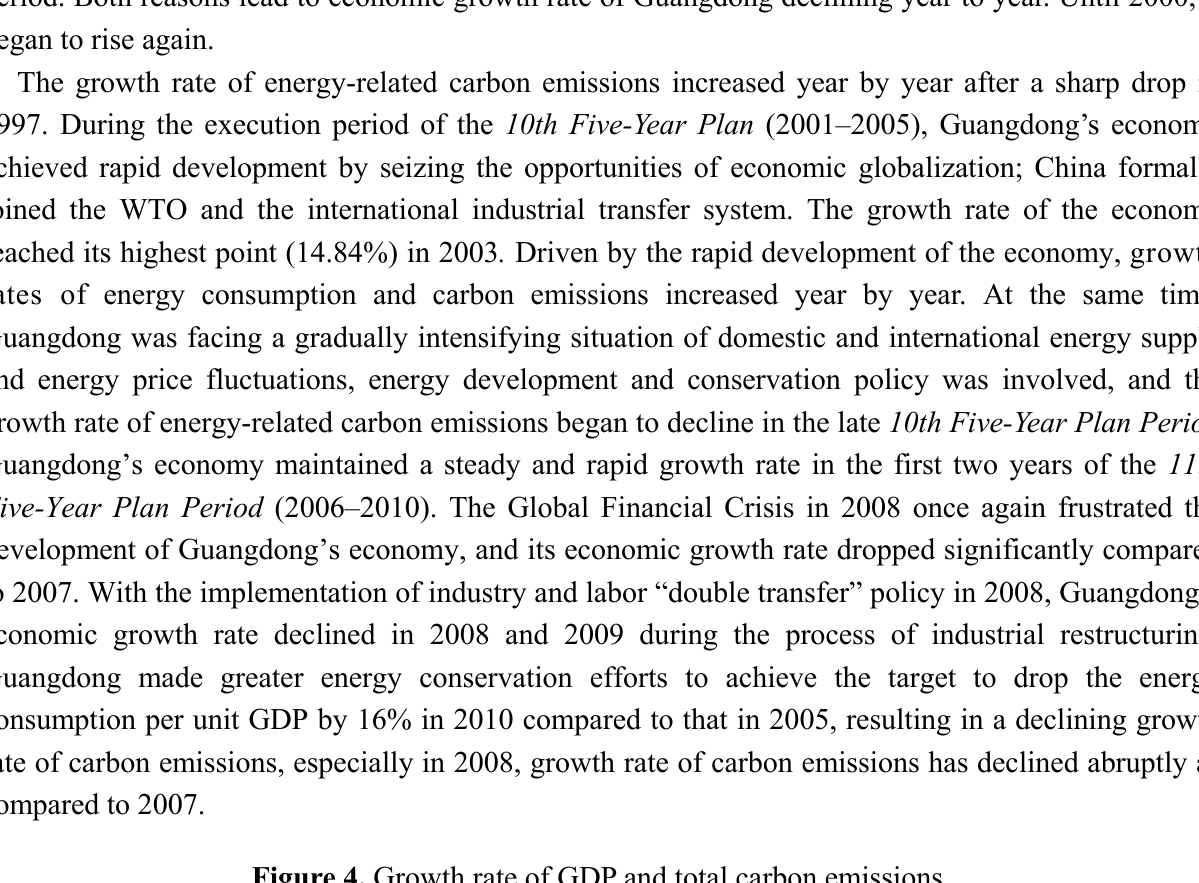
Figure 4. Growth rate of GDP and total carbon